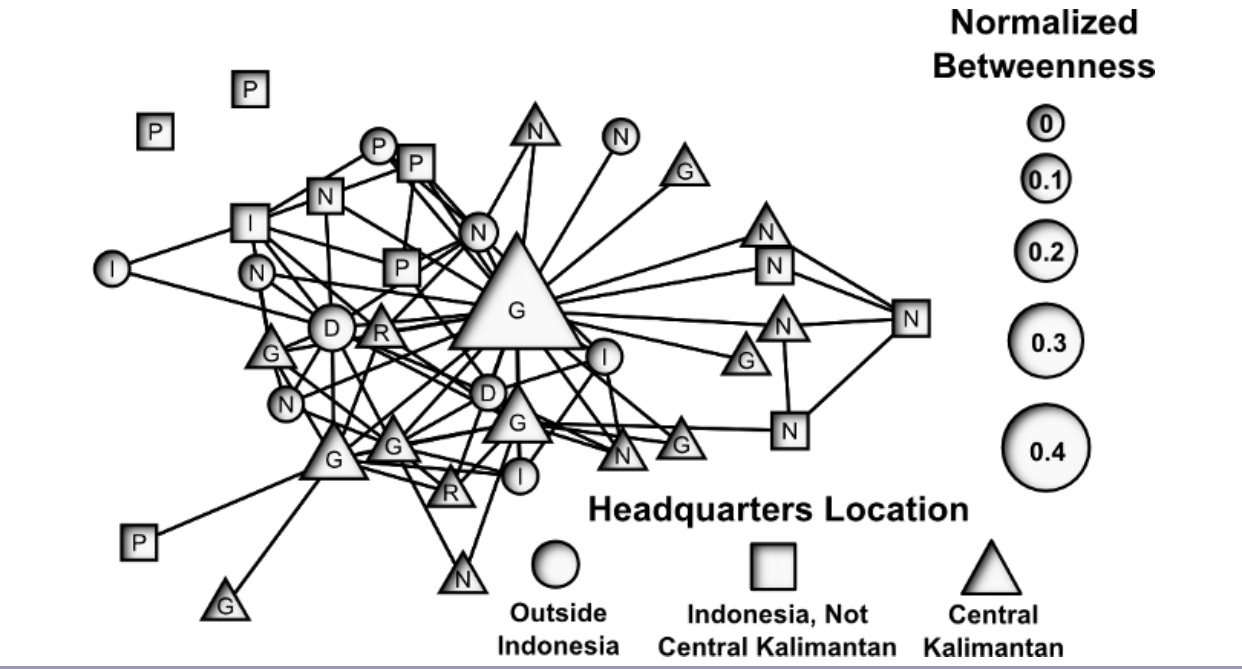
Fig. 2 . The REDD+ policy network in Central Kalimantan, Indonesia. Letters denote organization type (G = Provincial Government; N = Nongovernmental Organization; R = Research/Academic Organization; D = Donor Government Agency; I = International Organization). Nodes are scaled by normalized betweenness centrality (Freeman 1978), defined by a count of the number of shortest paths between all pairs of nodes in the network incident on a given node. Calculated in statnet (Handcock et al. 2003) and visualized with ggplot2 (Wickham 2009) in R 3.0.1 (R Development Core Team